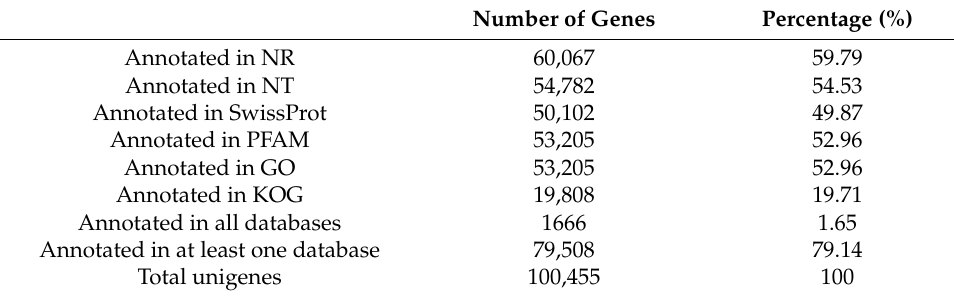
Table 3. Statistics of gene annotation success